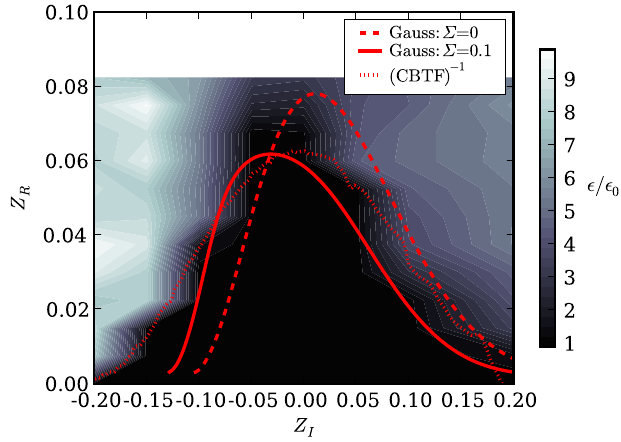
FIG. 11. (Color) Simulation scan of the stability boundary in the normalized impedance plane for a double rf wave and (cid:1) (cid:7) 0 : 1 . The bunch length of the initially matched Gaussian distribution (cid:7) 60 (cid:12) . The red curves represent the stability boundaries is (cid:1) m obtained from the dispersion relation equation (28) for (cid:1) (cid:7) 0 (dashed curve) and (cid:1) (cid:7) 0 : 1 (solid curve). The dotted red curve represents the stability boundary obtained from the CBTF (see Sec. VIII) for (cid:1) (cid:7) 0 : 1 .